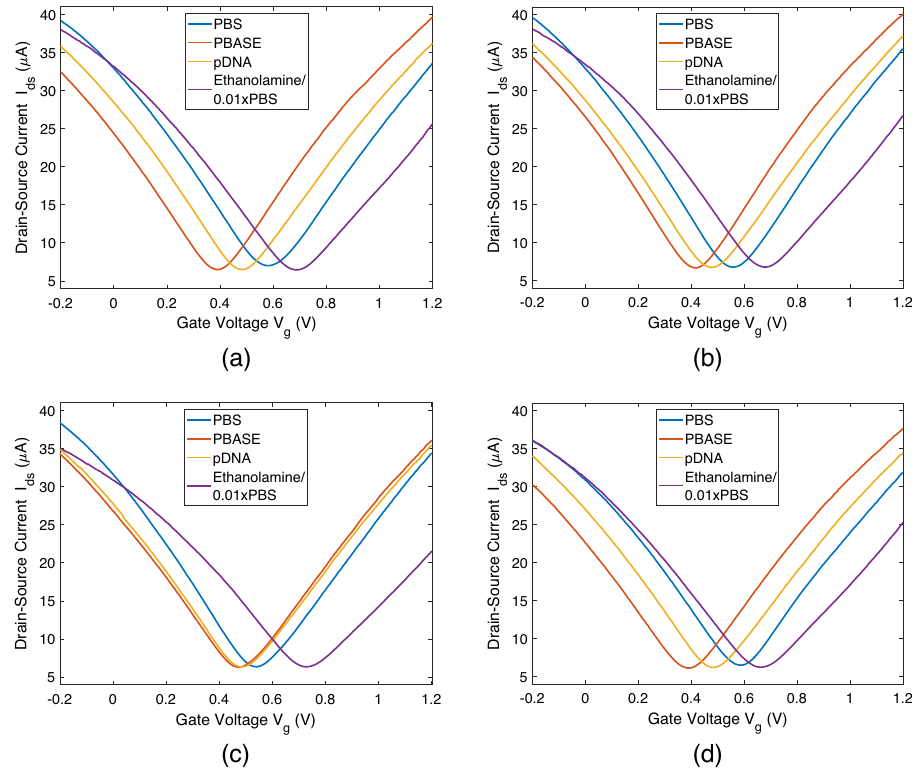
Figure 9. Transfer characteristics of four channels at different steps of functionalisation in terms of drain- source current I ds as a function of varying gate voltage V g with sweep rate 140 mV/s. In all measurements drain- 0.1 source voltage is held constant at V ds =